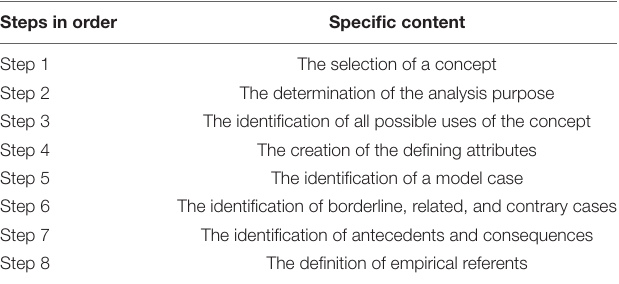
TABLE 1 | The eight stages of the concept analysis method conceived by Walker and